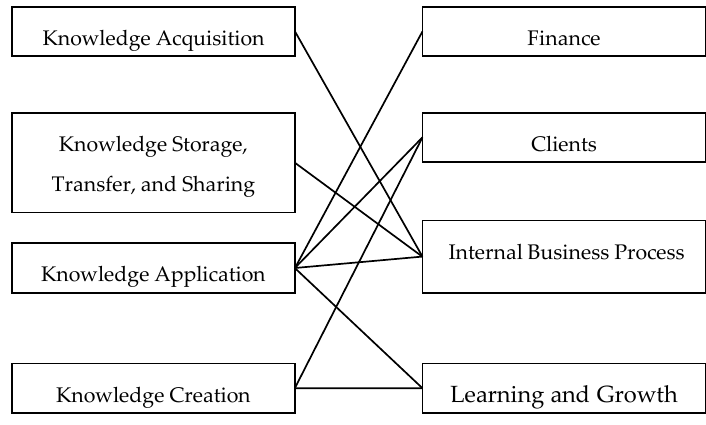
Figure 1. The mapping between KM and BSC.